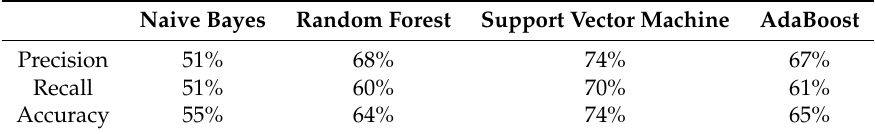
Table 6. The precision and recall using leave one subject out cross-validation is presented here. Naive Bayes Random Forest Support Vector Machine